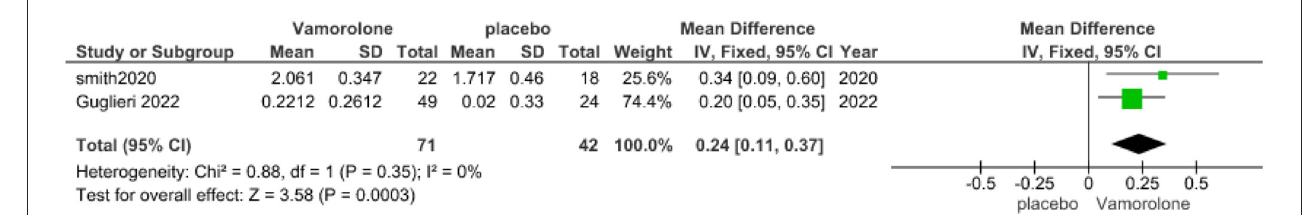
FIGURE3 TTRW outcome vamorolone vs. placebo.